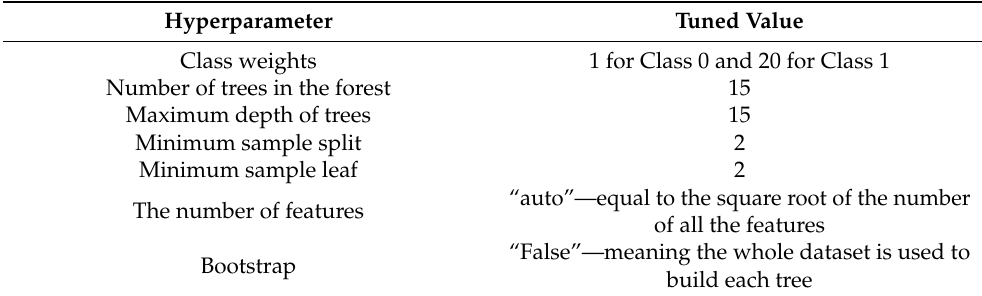
Table 4. The selected hyperparameters of the RF model.